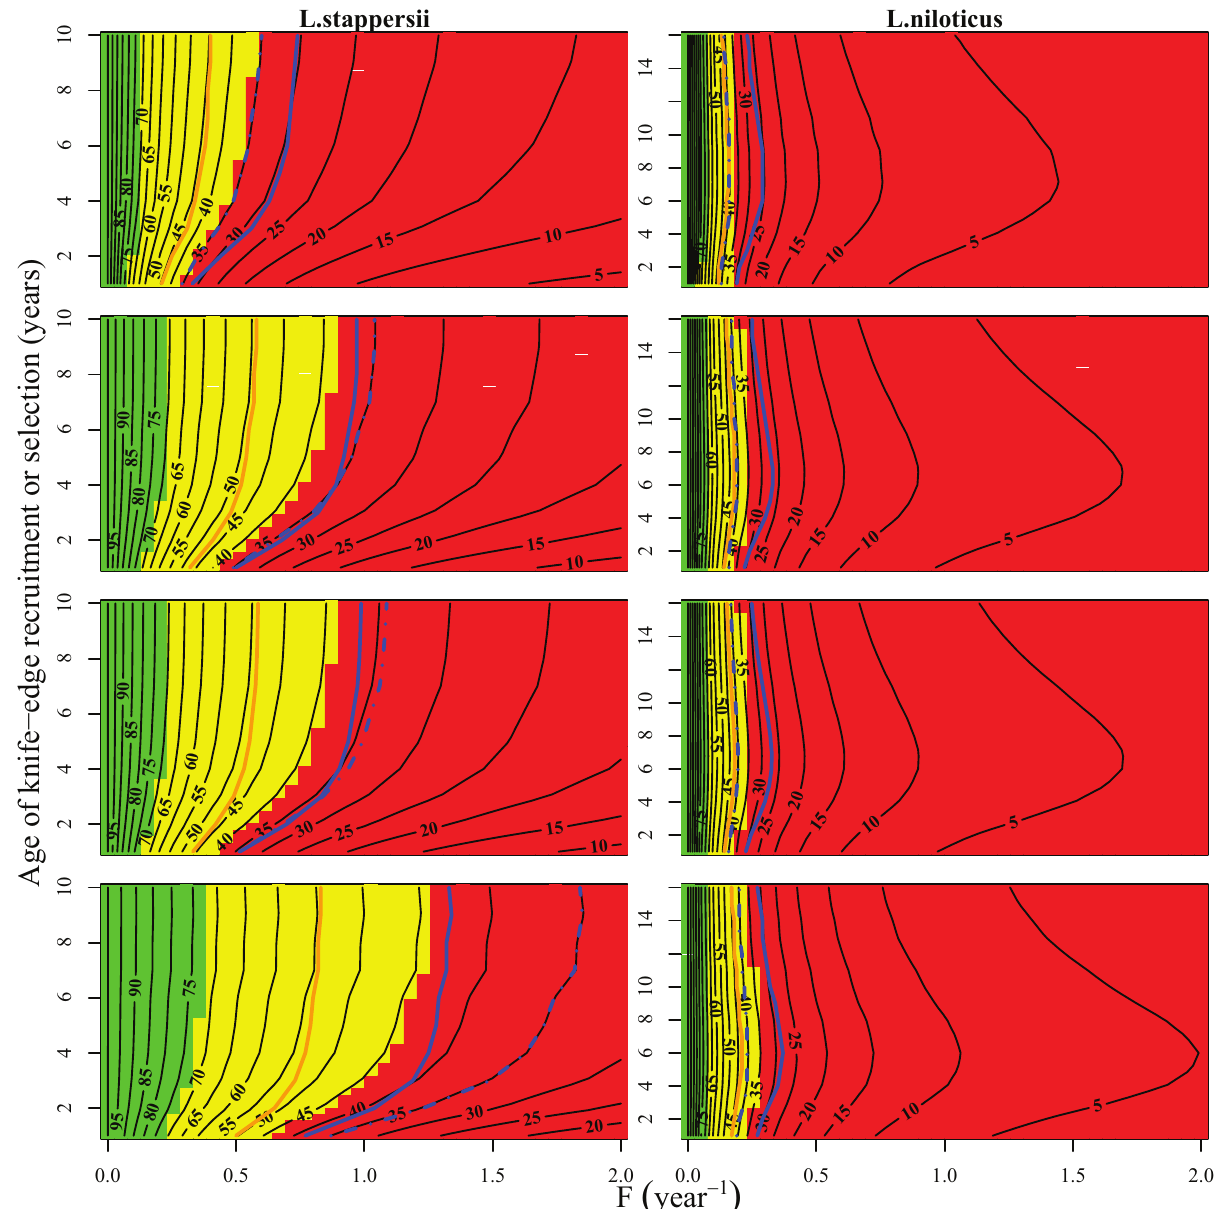
Fig. 5. Isopleths of, from top to bottom, the 2.5% percentile, median, mean, and 97.5% percentile of CSPR involving a declining survivorship (%) as a function of fi shing mortality ( F ) and the age of knife-edge recruitment or the age of knife-edge selection for L. stappersii in Lake Tanganyika (left panels) and L. niloticus in Lake Victoria (right panels). The plots also show the variations of the 2.5% percentile, median, mean, and 97.5% percentile of F CYPR (blue solid line), F 0.1 (orange solid line), as well as F 35%CSPR for L. stappersii and F 40%CSPR for L. niloticus (blue dash-dotted line) against the age of knife-edge recruitment. Areas shaded by the red color, yellow color, and green color are, respectively, topographies of low CSPR, intermediate CSPR, and high CSPR. If F CYPR , F 0.1 , or F at a target CSPR is treated as the fi shing mortality target, the region below and to the right of the corresponding lines represents recruitment-over fi shing.